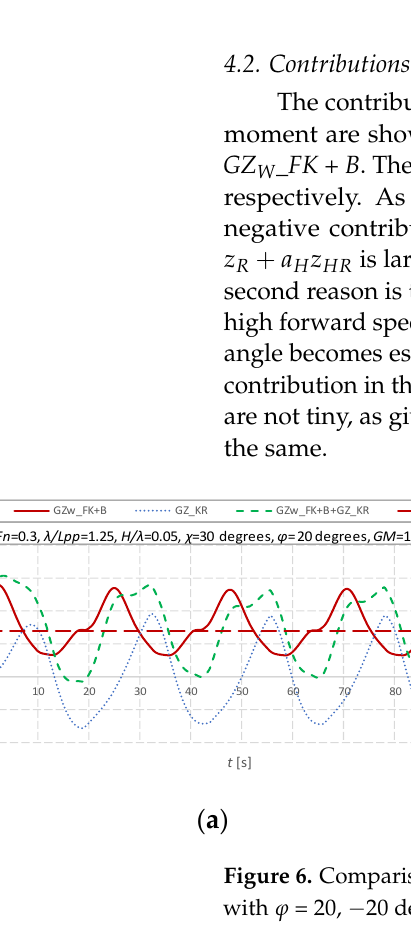
degrees, ( a ) GZ W _B ; ( b ) GZ W _FK only.